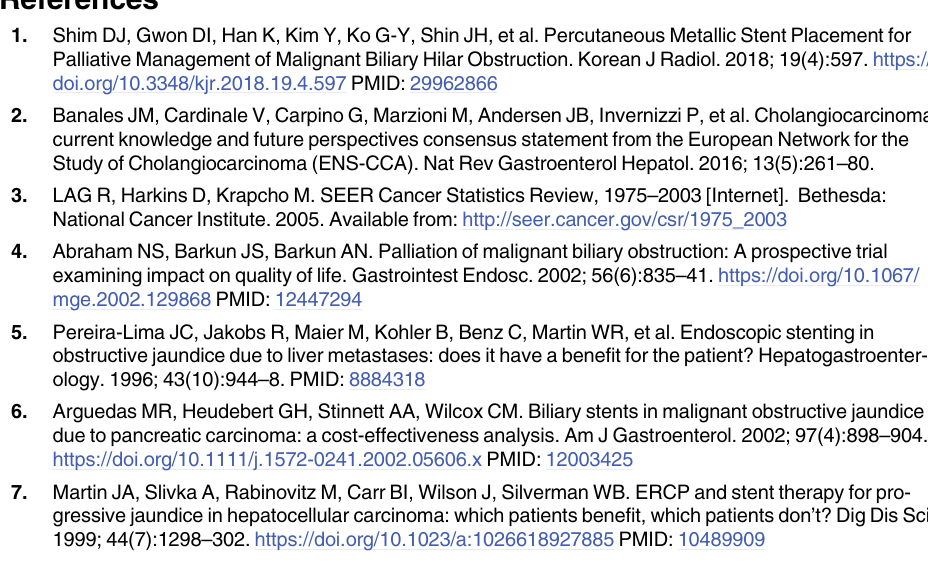
S5 Table. Cholangiographic findings and endoscopic interventions of patients with and without bilirubin normalization within 6 weeks after endoscopic drainage in the deriva- tion